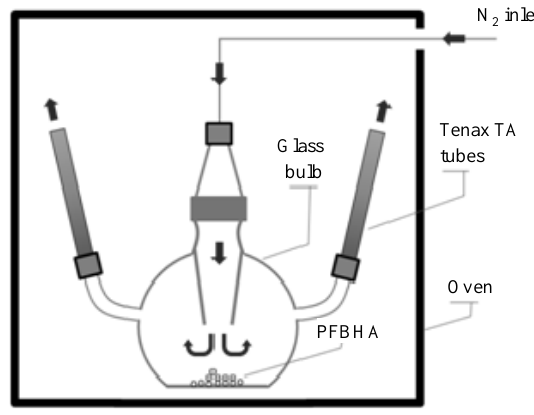
Fig. 4. The PFBHA coating process scheme for Tenax TA tubes. is sufficient to derivatise (i.e. is 10 times higher than) a car- bonyl compound at a concentration of around 1 mg m − 3 (for an average molecular weight of 100). The glass bulb and sor- bent tubes were kept at 110 ◦ C in an oven during the